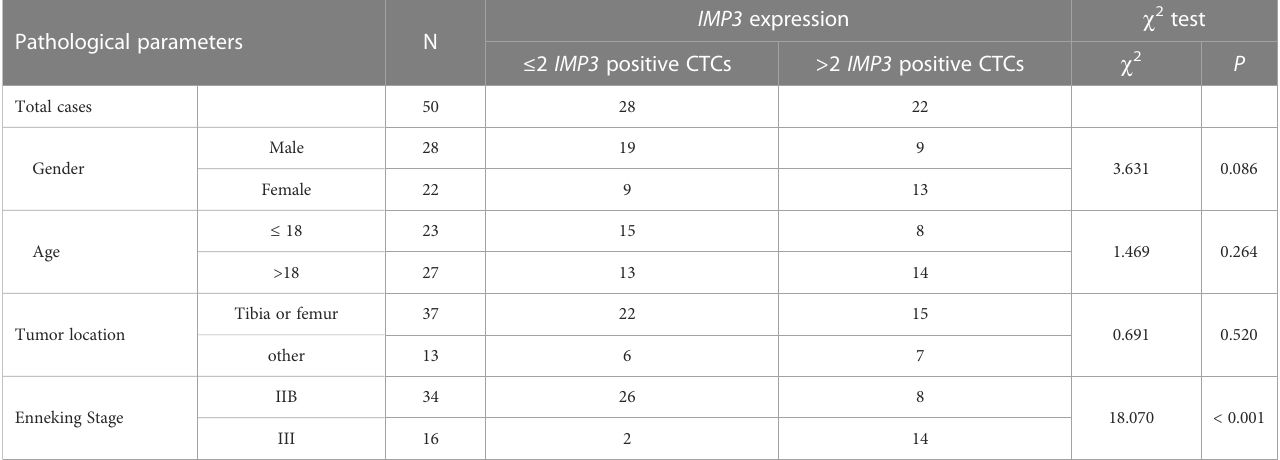
TABLE 5 Relationship between IMP3 expression in CTCs and clinical pathological features.